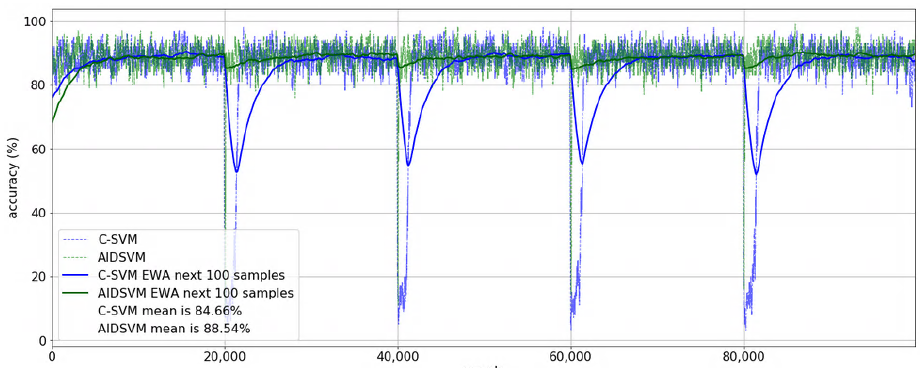
Figure 4. Accuracy comparison between fixed-window C-SVM and adaptive-window AIDSVM, on the SINE1 dataset. The instant accuracy evaluated on the next 100 samples is depicted with blue (C-SVM) and green (AIDSVM). Exponentially weighted accuracy (EWA) is also shown, as well as the mean